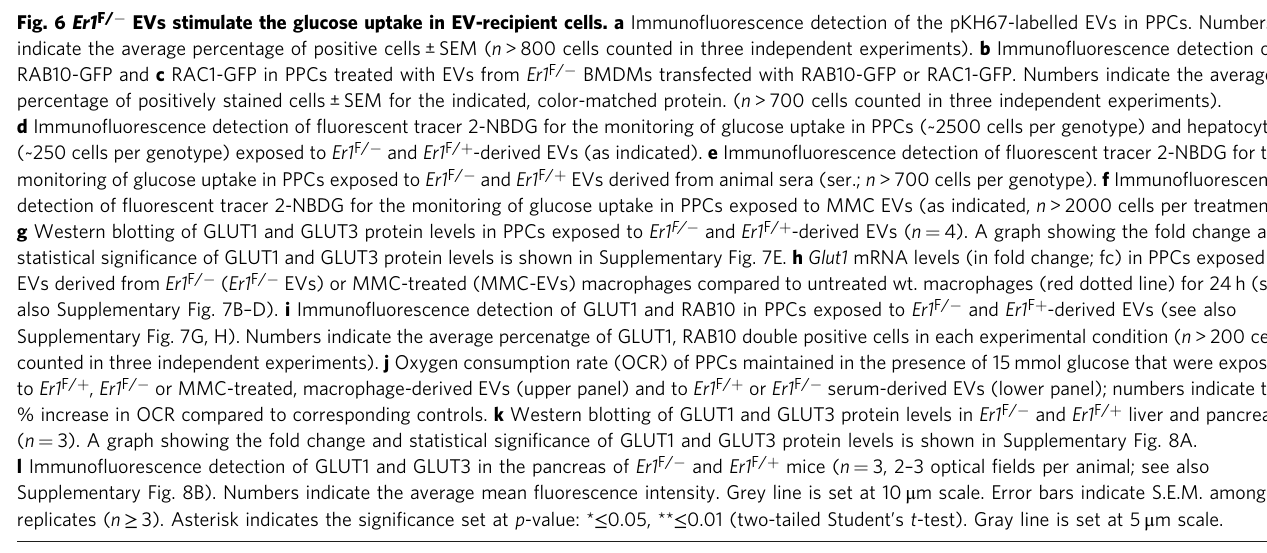
Fig. 6 Er1 F/ − EVs stimulate the glucose uptake in EV-recipient cells. a Immuno fl uorescence detection of the pKH67-labelled EVs in PPCs. Numbers indicate the average percentage of positive cells ± SEM ( n > 800 cells counted in three independent experiments). b Immuno fl uorescence detection of RAB10-GFP and c RAC1-GFP in PPCs treated with EVs from Er1 F/ − BMDMs transfected with RAB10-GFP or RAC1-GFP. Numbers indicate the average percentage of positively stained cells ± SEM for the indicated, color-matched protein. ( n > 700 cells counted in three independent experiments). d Immuno fl uorescence detection of fl uorescent tracer 2-NBDG for the monitoring of glucose uptake in PPCs (~2500 cells per genotype) and hepatocytes (~250 cells per genotype) exposed to Er1 F/ − and Er1 F/ + -derived EVs (as indicated). e Immuno fl uorescence detection of fl uorescent tracer 2-NBDG for the monitoring of glucose uptake in PPCs exposed to Er1 F/ − and Er1 F/ + EVs derived from animal sera (ser.; n > 700 cells per genotype). f Immuno fl uorescence detection of fl uorescent tracer 2-NBDG for the monitoring of glucose uptake in PPCs exposed to MMC EVs (as indicated, n > 2000 cells per treatment). g Western blotting of GLUT1 and GLUT3 protein levels in PPCs exposed to Er1 F/ − and Er1 F/ + -derived EVs ( n = 4). A graph showing the fold change and statistical signi fi cance of GLUT1 and GLUT3 protein levels is shown in Supplementary Fig. 7E. h Glut1 mRNA levels (in fold change; fc) in PPCs exposed to EVs derived from Er1 F/ − ( Er1 F/ − EVs) or MMC-treated (MMC-EVs) macrophages compared to untreated wt. macrophages (red dotted line) for 24 h (see also Supplementary Fig. 7B – D). i Immuno fl uorescence detection of GLUT1 and RAB10 in PPCs exposed to Er1 F/ − and Er1 F + -derived EVs (see